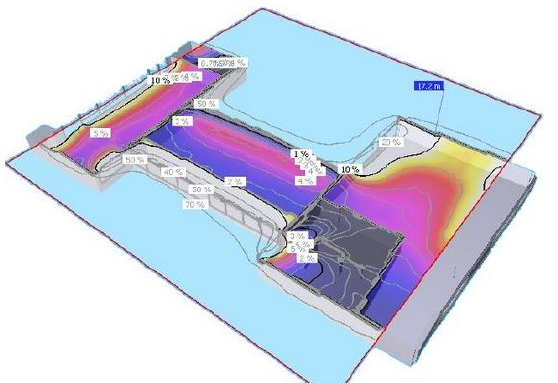
Figure 14. Cartography of natural illumination of the appartement